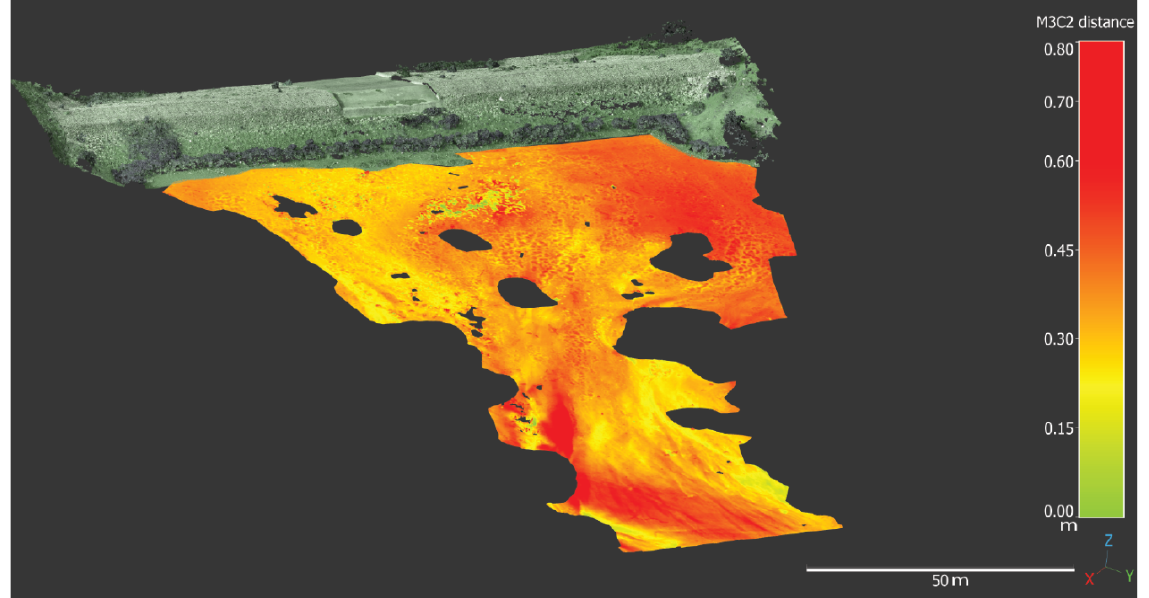
Figure 8. Annual topsoil vertical difference estimated using the M 3 C 2 algorithm application (2020–2021).